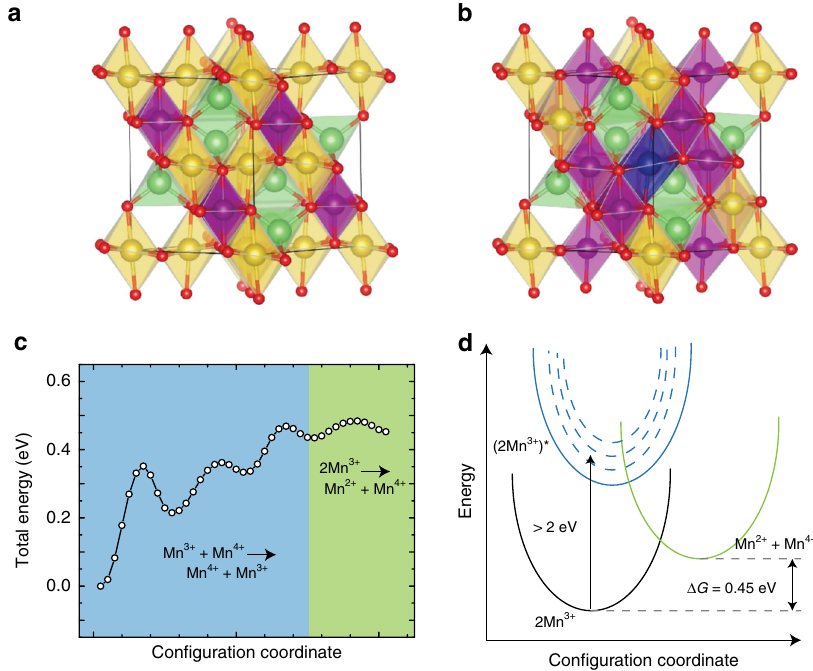
Fig. 4 Atomistic studies of the proposed photo-induced charge separation mechanism in LMO. a , b Structural model of bulk stoichiometric LMO without and with disproportionation, respectively. Green, red, purple, yellow, blue spheres represent Li, O, Mn 4 + , Mn 3 + , and Mn 2 + sites, respectively. c Relative ground state total energy along the transition path from the ground state to the disproportionated state. The fi rst transition is a concerted electron exchange between two Mn 3 + and Mn 4 + sites, the second and third transition are single electron exchange processes between Mn 3 + and Mn 4 + , and the last transition is the disproportionation reaction. d Schematic of the Eq. 3 scenario where photo-excited electron transfer process occurs from the ground state, through the excited states (2[Mn 3 + ]*) to the disproportionated state (2Mn 3 + → Mn 2 + + Mn 4 +